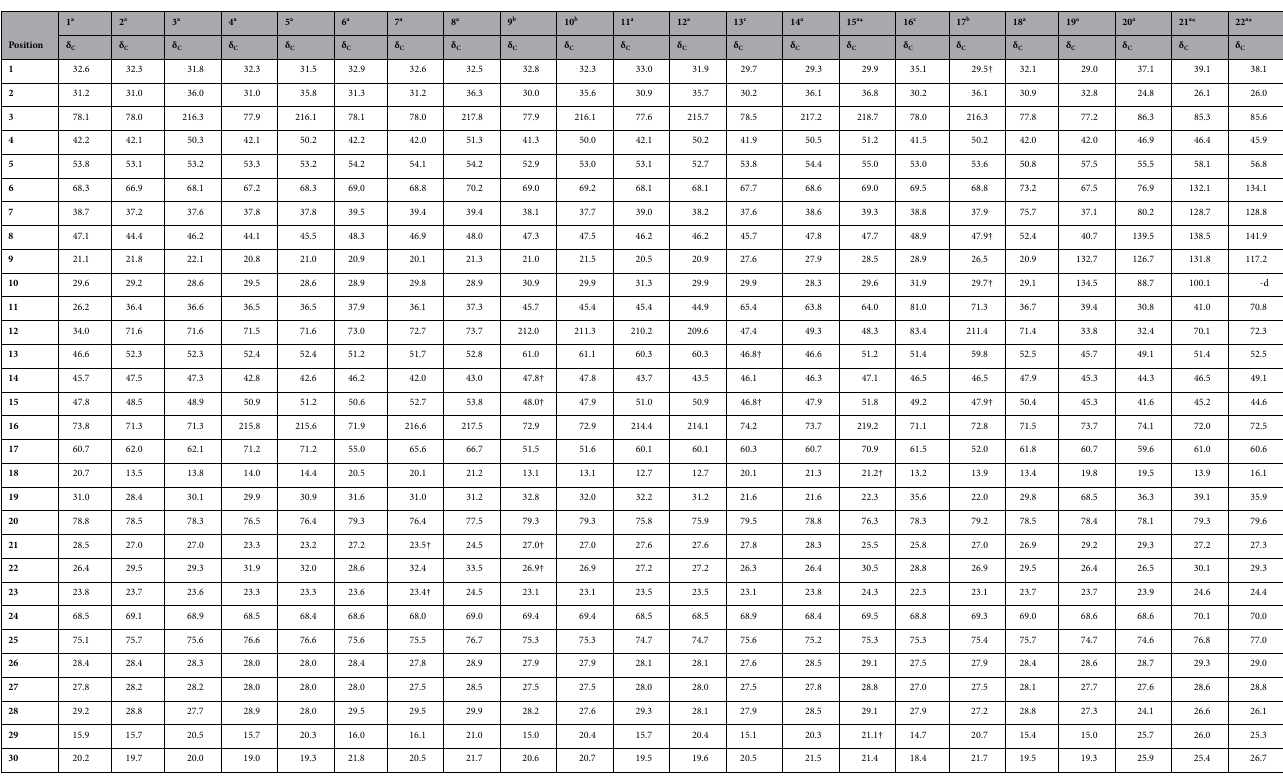
Table 5. 13 C NMR spectroscopic data of compounds 1 – 22 (100 MHz and *125 MHz). a In C 5 D 5 N. b In CDCl 3 . c In CD † Overlapped signals. d Not 3 OD and a drop of C 5 D 5 N.